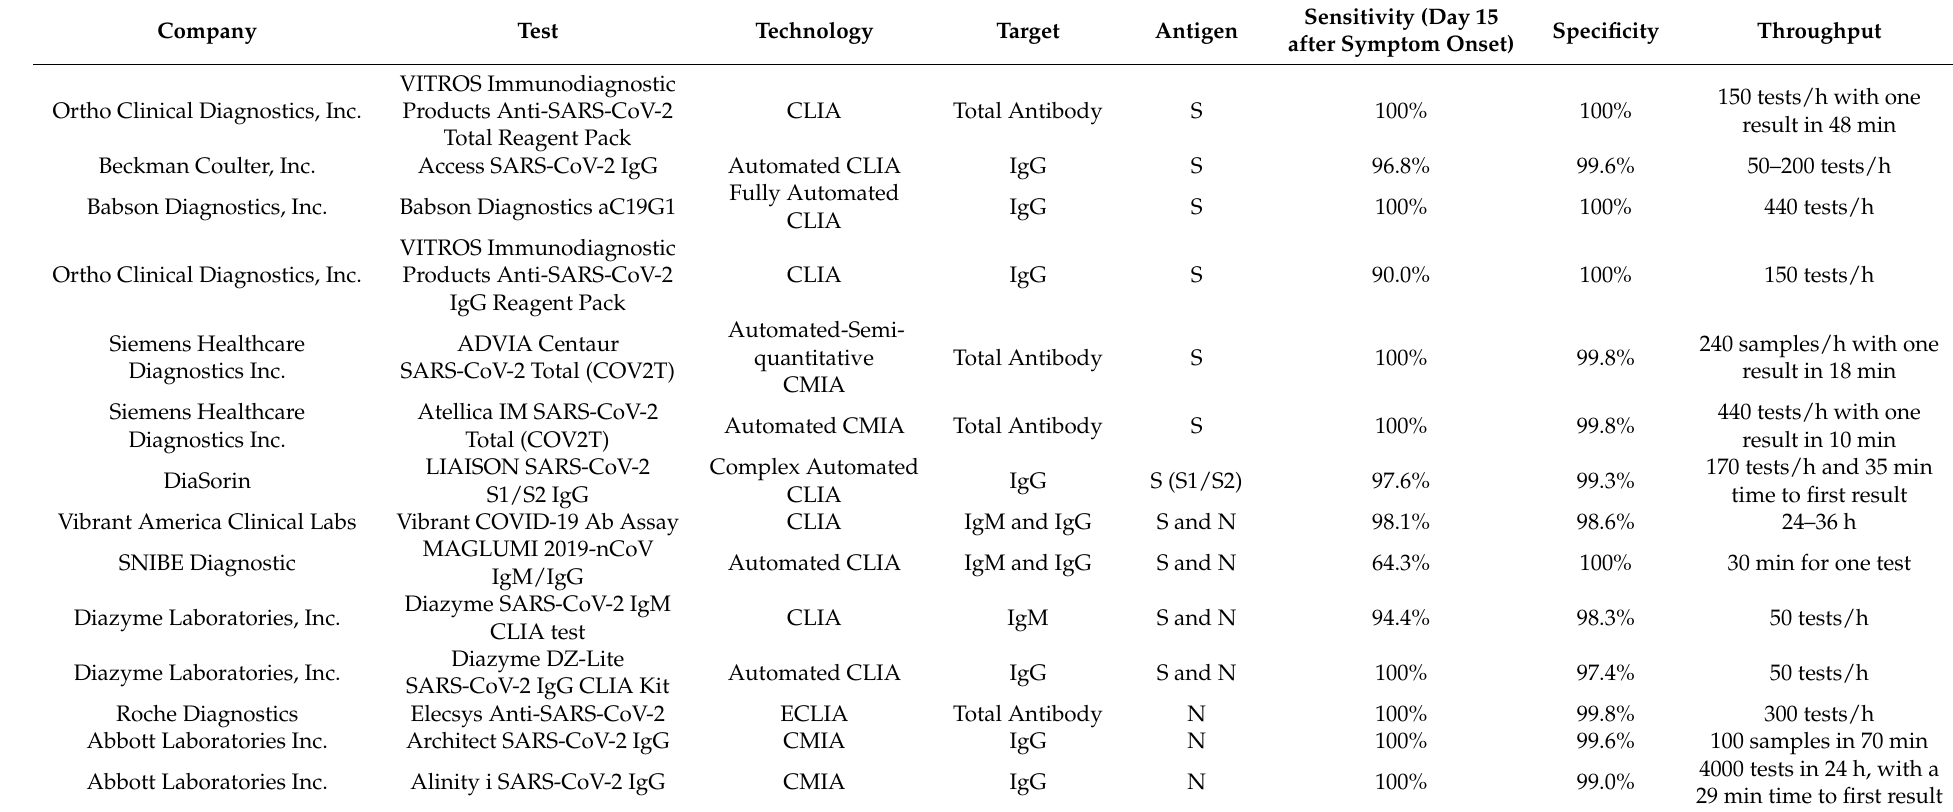
Table 1. Selected approved CLIA-based tests as Lab-based and high throughput COVID-19 detection strategies based on FDA Serology Test Performance [44]. Company